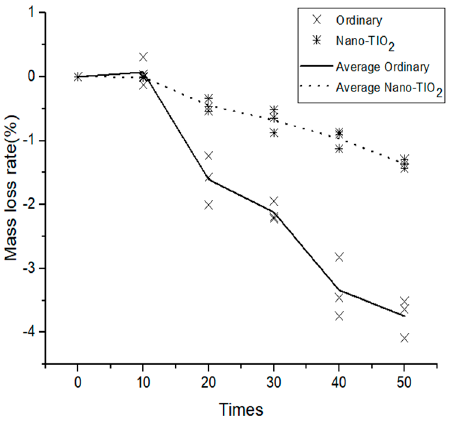
Figure 2. The influence of dry–wet cycles on the concrete mass-loss rate.